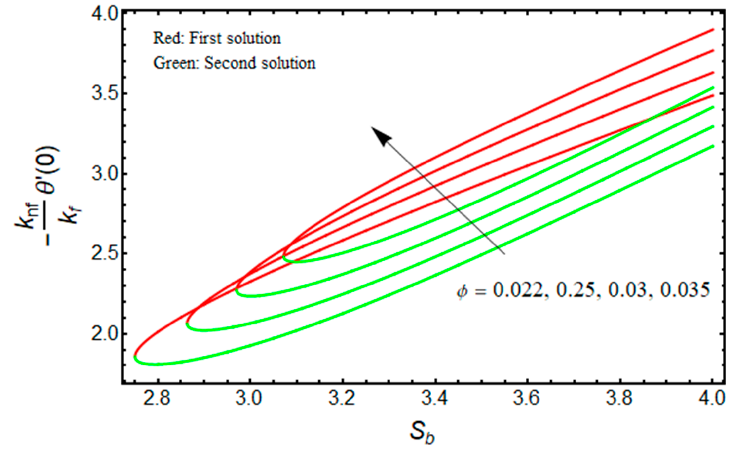
(cid:16) (cid:17) k nf / k f θ (cid:48) ( 0 ) versus S b when χ = 1, M b = 0.5, R d = 1.5, m = 1. Figure 11. Effect of φ on